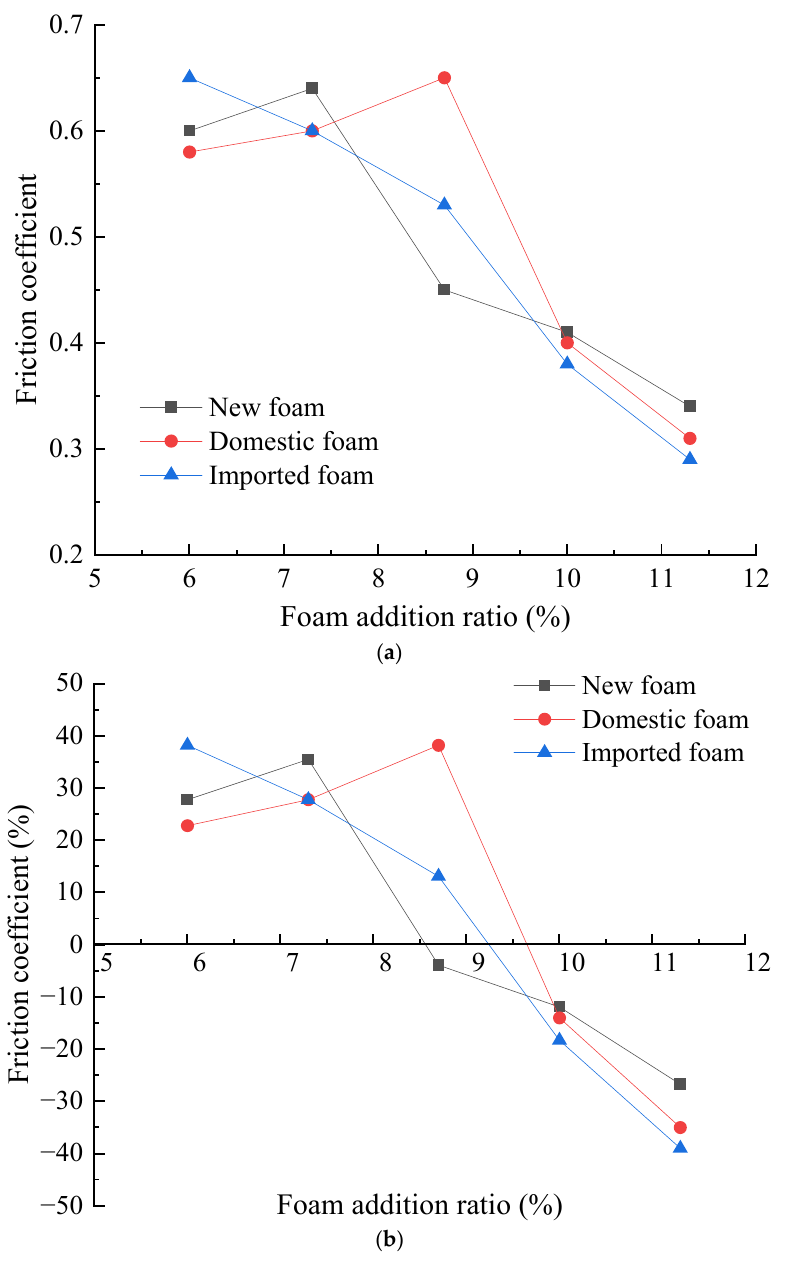
Figure 13. Comparison of the friction coefficient and friction coefficient change rates of sand soil modified by different foam agents. ( a ) Friction coefficient change curve. ( b ) Friction coefficient change rate change curve.